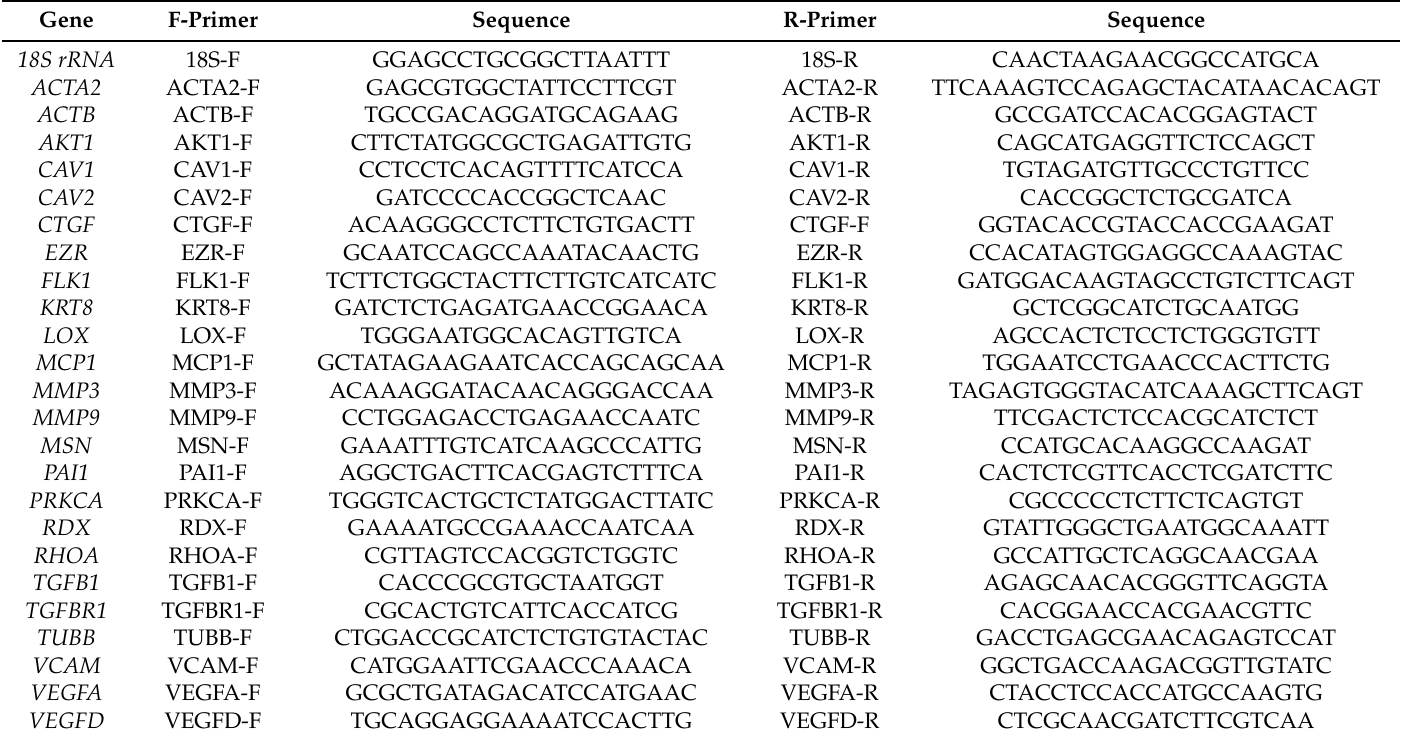
Table 1. Primer used for quantitative real-time